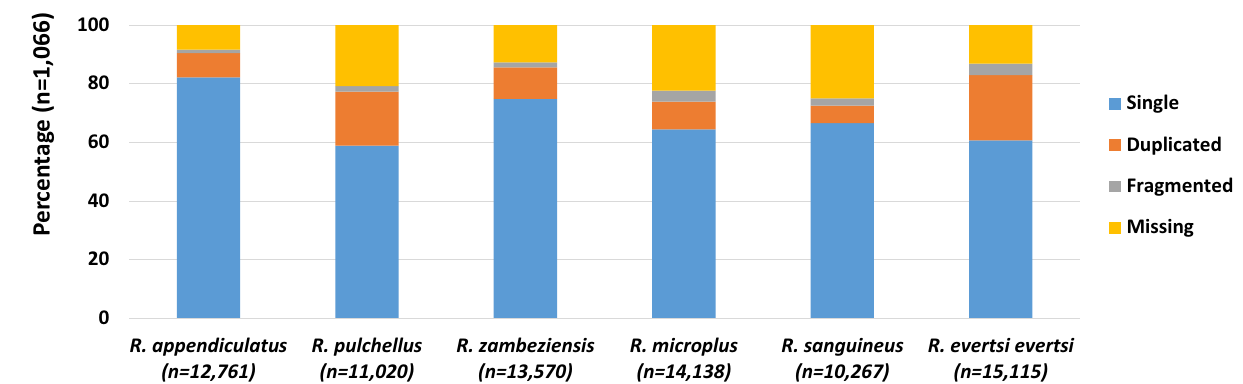
Figure 1. Comparison of BUSCO values of Rhipicephalus evertsi evertsi and transcriptomes published from other Rhipicephalus species. Indicated in parenthesis is the number of transcripts from each transcriptome submitted to BUSCO analysis. The percentage of single, duplicated, fragmented and missing genes are presented as a percentage fraction contributing to the whole transcriptome. The number of ORFs analysed are indicated in